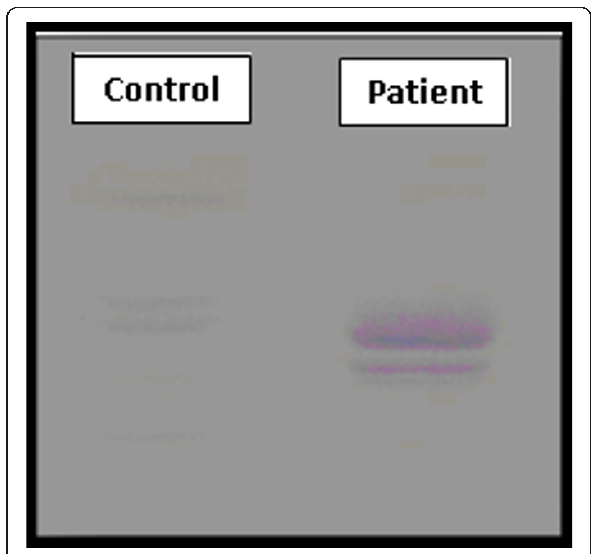
Figure 1 The sulfatiduria profile of the patient compared with a control